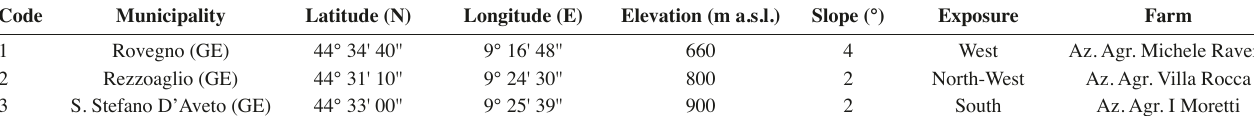
Tab. 1: Characteristics of the three experimental fields.